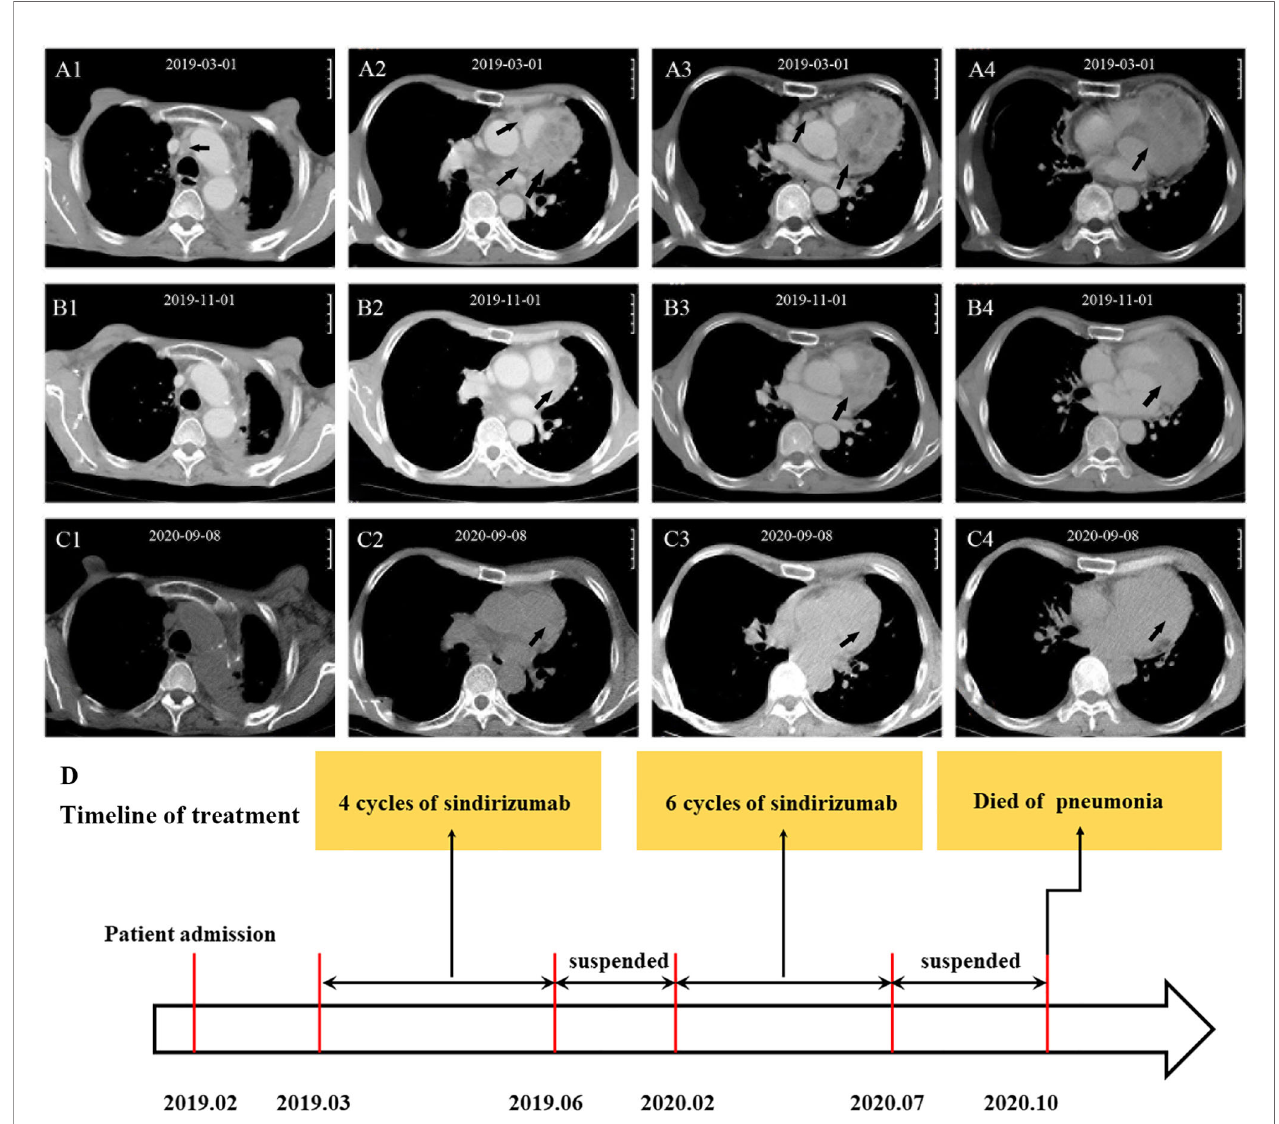
FIGURE 3 | CT scans before and after treatment and timeline of treatment. Before treatment (A1 – A4) : The arrows show multiple lymph node shadows at the left hilum of the lung and mediastinum and a round, soft-tissue mass at the left edge of the Cardiac margin. After treatment (B1 – B4) : The arrows show that the enlarged mediastinal lymph nodes disappeared and myocardial metastasis signi fi cantly shrank. Follow-up (C1 – C4) : myocardial metastasis continuously shrank. Timeline of treatment of the patient (D) : The arrow shows the whole process of diagnosis and treatment of the